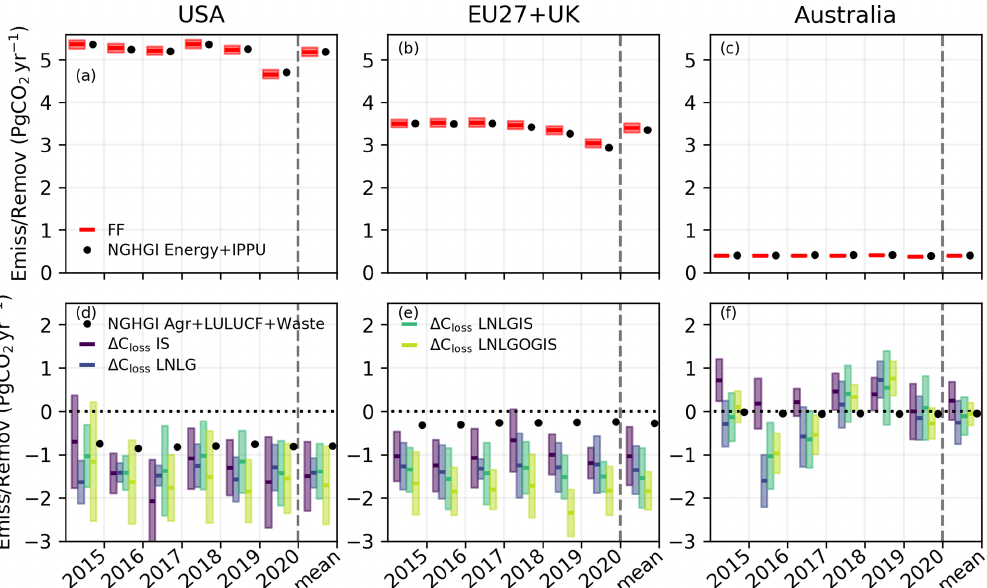
Figure 15. Emissions and removals of CO 2 from the (a–c) energy and IPPU categories and (d–f) agriculture, LULUCF and waste categories reported in NGHGIs and (cid:49)C loss for four OCO-2 MIP experiments (IS, LNLG, LNLGIS, LNLGOGIS). Values are provided for individual years and the 2015–2020